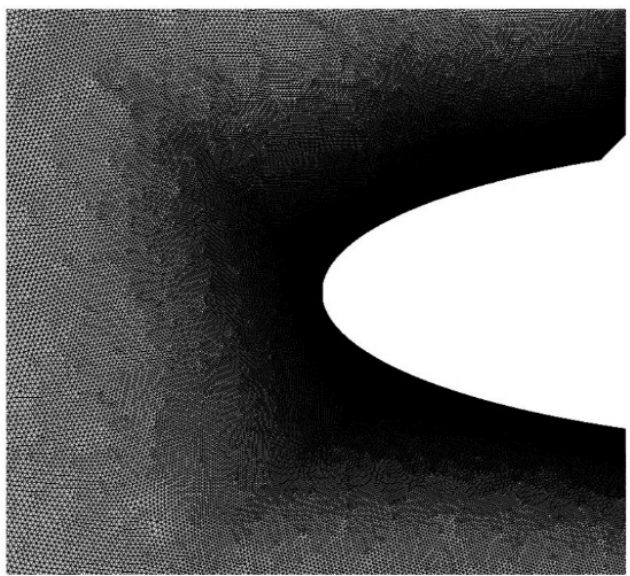
Figure 8. Double ellipsoid mesh diagram (part).